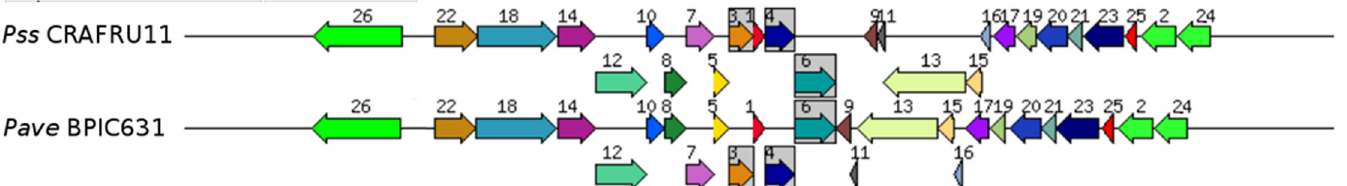
Fig 6. Structure of the genomic island Pcor GI1 of about 20 kb found in all nine pseudomonad strains infecting Corylus avellana trees. It was obtained using the SEED viewer comparative tool. The genomic structure of the island resulted conserved among the strains. Two representative structure regarding Pseudomonas syringae pv. syringae CRAFRU 11 and P . avellanae BPIC 631 are shown. Gene legend is shown in S2